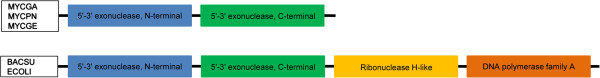
Domain organization of Exo protein of
M. gallisepticum
,
M. genitalium,
and
M. pneumoniae
in comparison to DNA polymerase I of
E. coli
and
B. subtilis
.